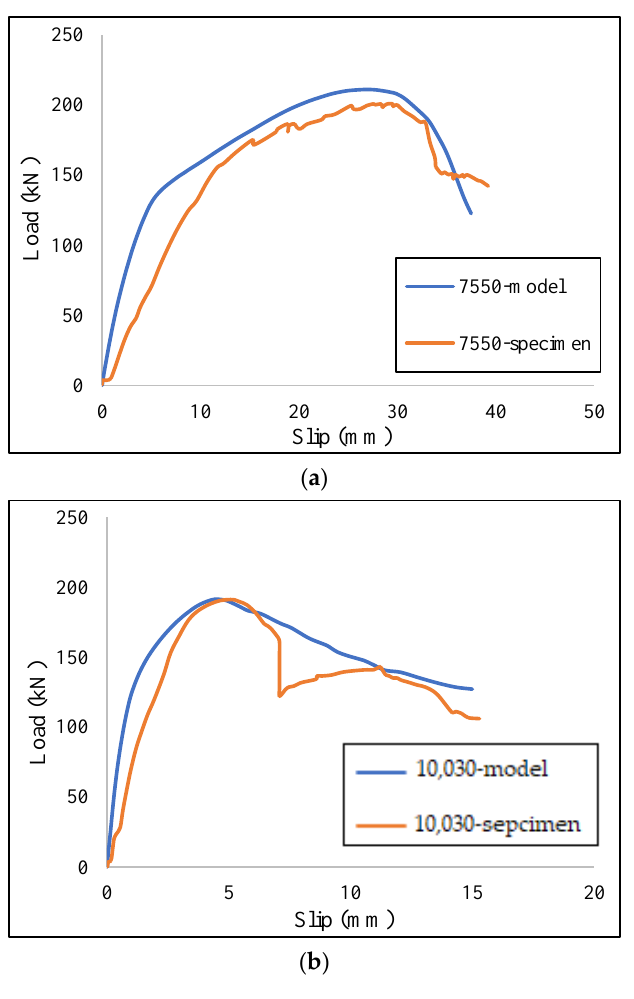
Figure 12. Comparative load – slip curves for ( a ) C7550 type connector at 550 °C, and ( b ) C10030 type connector at ambient temperature.